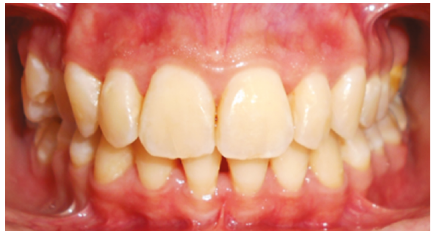
Figure 5: Final front view 2 years post treatment.